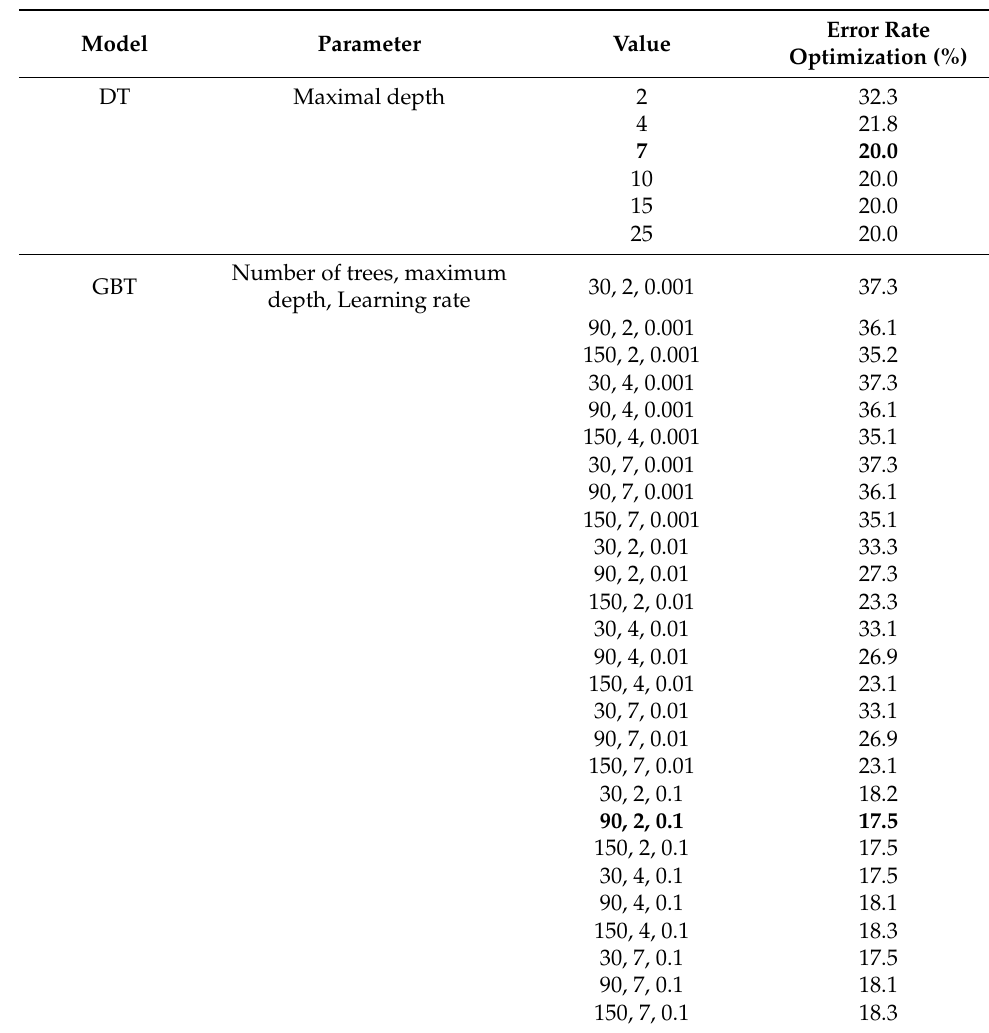
Table 3. Tuning hyper-parameters of DT and GBT